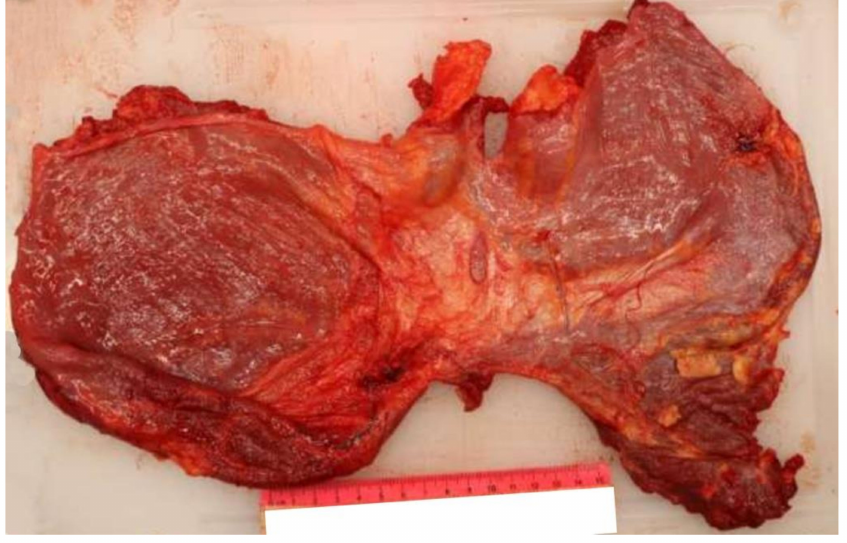
Figure 3. In this picture, it is plainly visible the diaphragm, with its subcardiac part (yellow arrow), without any lesion.